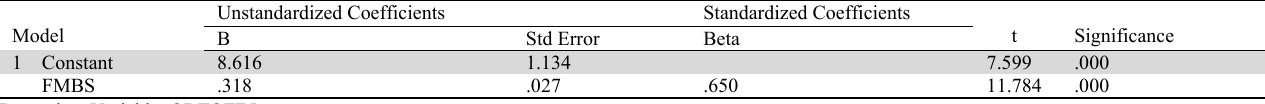
The results of regression